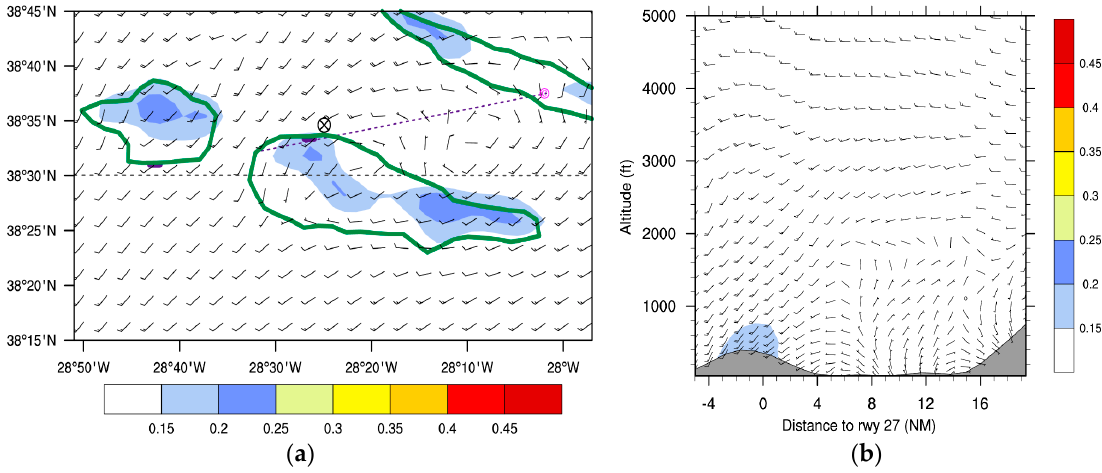
Figure 18. ( a ) Horizontal representation of EDR during Flight 2. The circled “X” mark identifies approximate aircraft position at 66 m. ( b ) Cross-sectional representation of EDR.